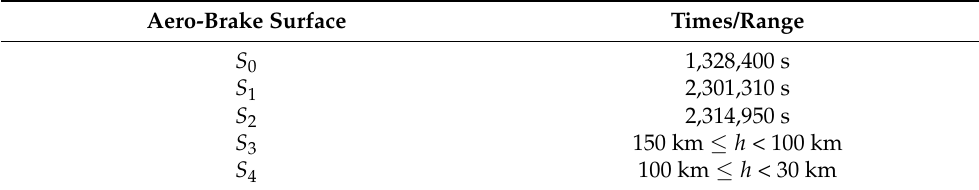
Table 2. Aero-brake surface deployment schedule along the re-entry